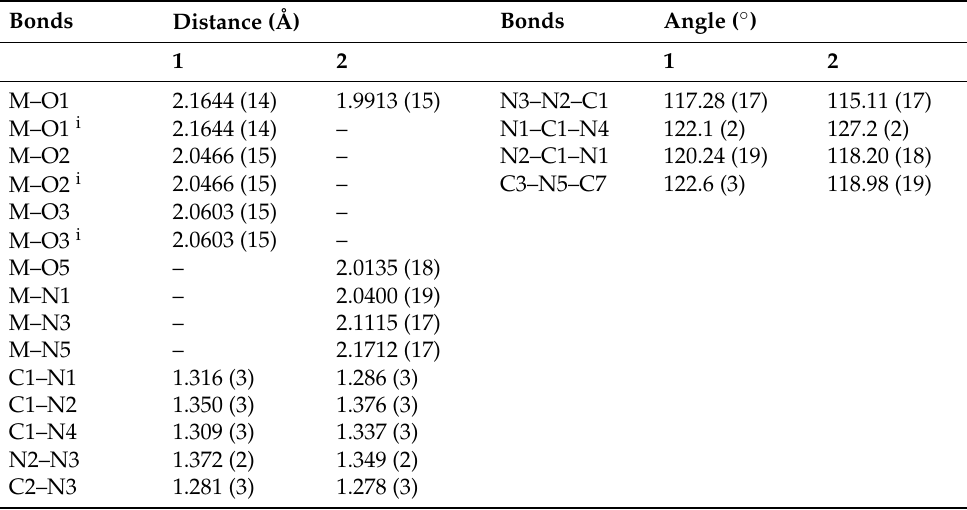
Table 1. Selected structural data (Å, ◦ ) for the